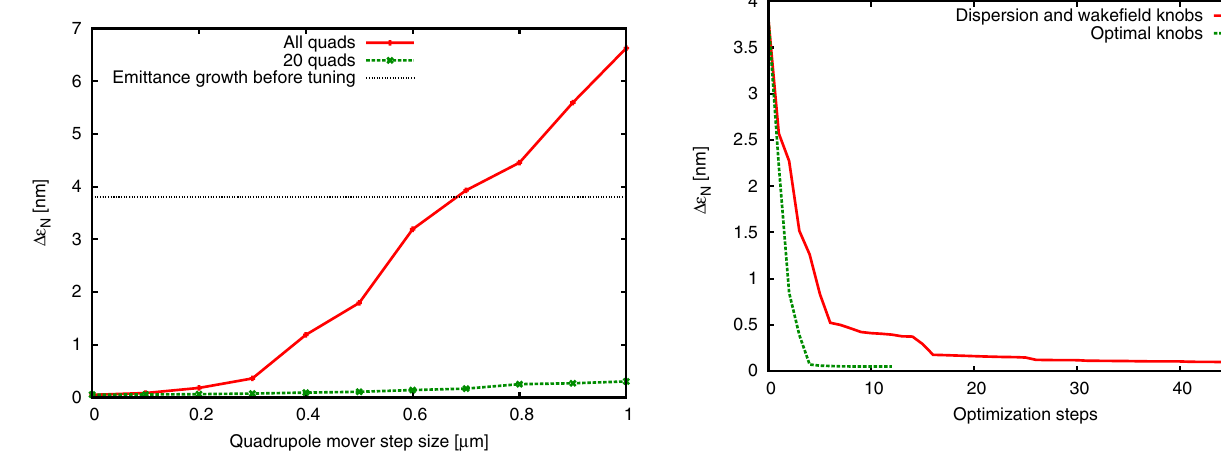
FIG. 24. Final emittance growth after tuning with four knobs assuming a finite mover step size. When all quadrupoles of ILC are used, the knobs become sensitive to step size. This can be cured by reducing the number of quadrupoles to 20.